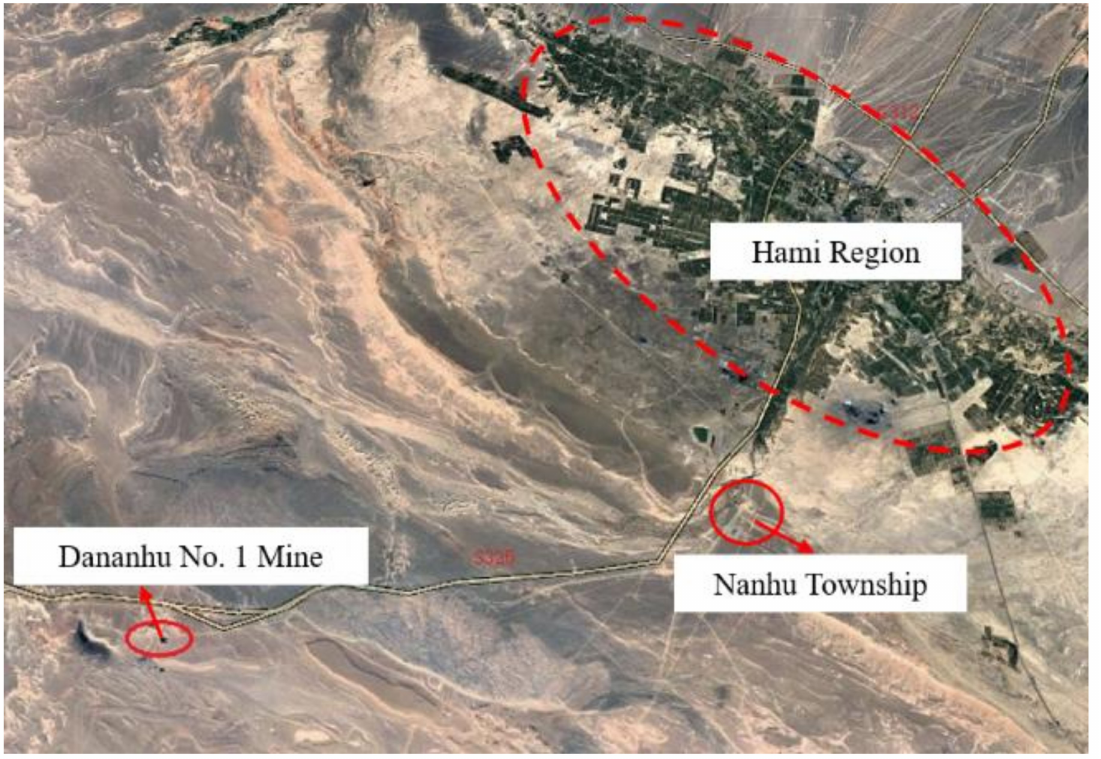
Figure 2. Traffic location of Dananhu No. 1 Coal